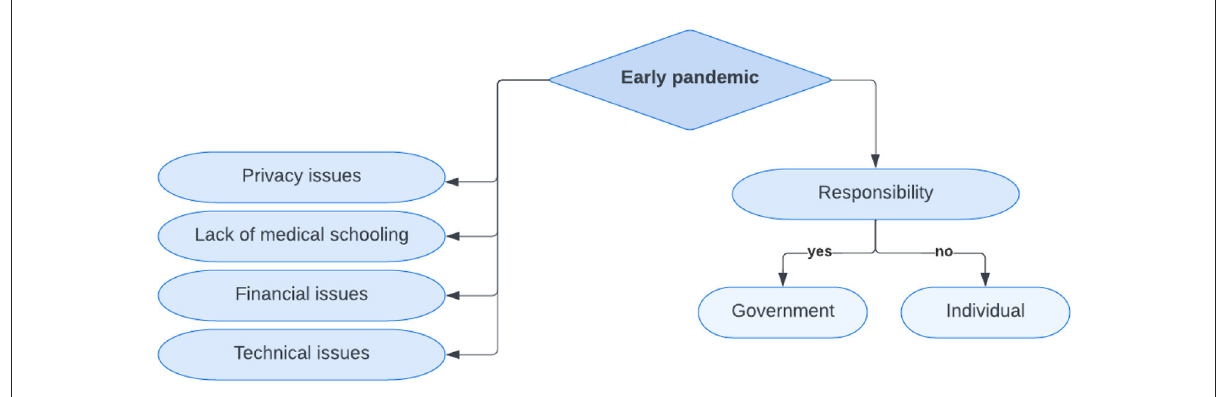
FIGURE2 Overview of themes in newspaper articles – Early